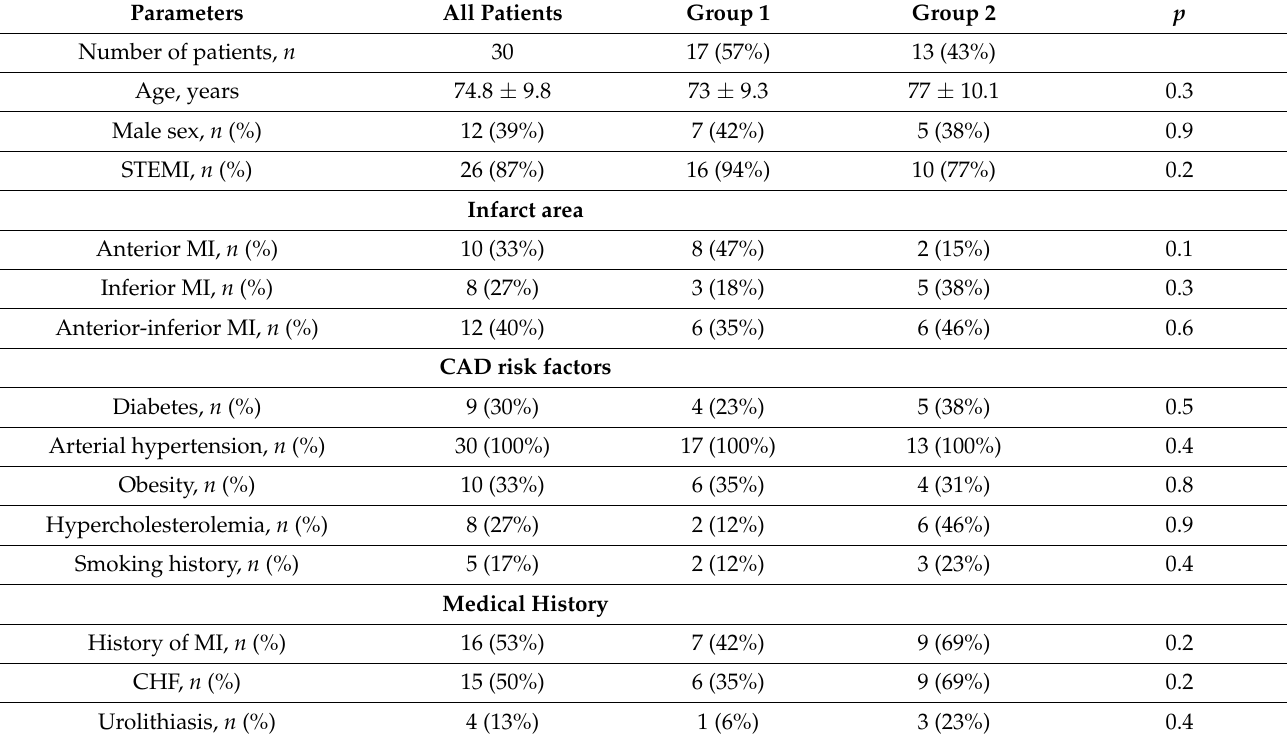
Table 1. Clinical and anamnestic characteristics of patients ( n =